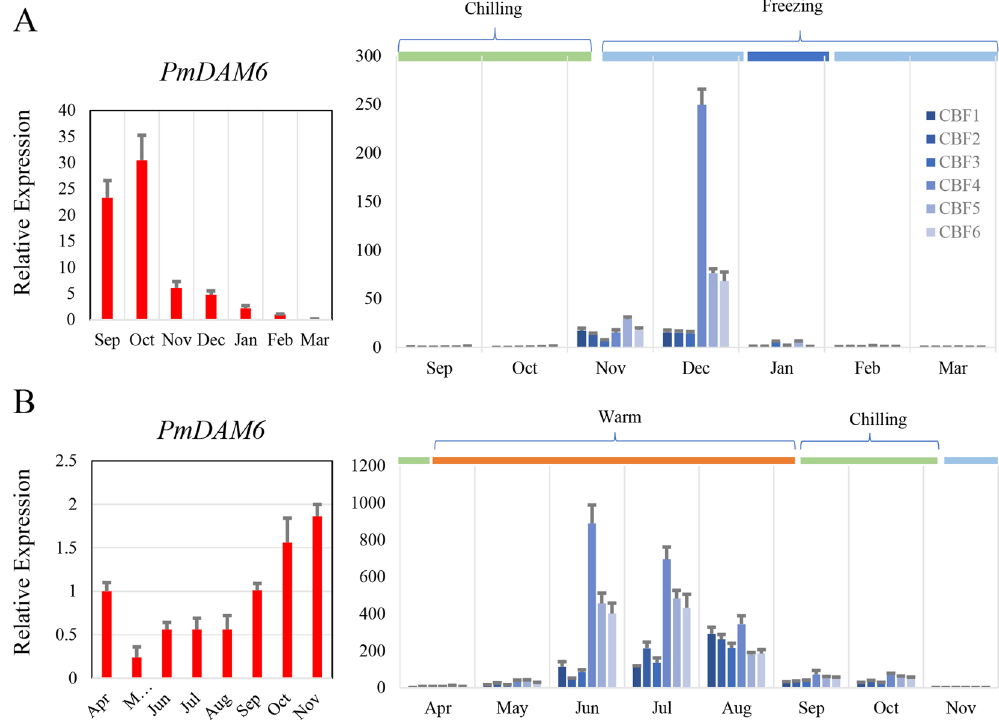
Figure 5. Expression patterns of PmDAMs and PmCBFs in leaf buds and mature leaves. ( A ) Gene expressions in the leaf buds. ( B ) Gene expressions in the leaves. (Warm: higher than 20 °C, Chilling: lower than 20 °C, Freezing: lower than 0